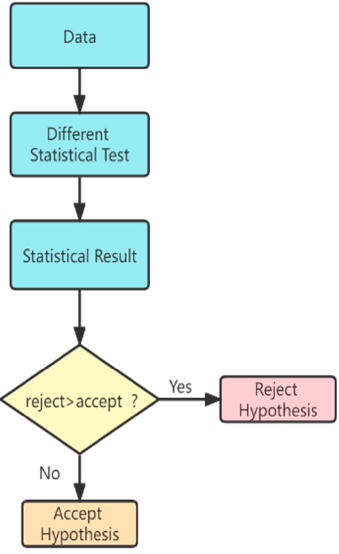
Figure 4. Discrimination module.